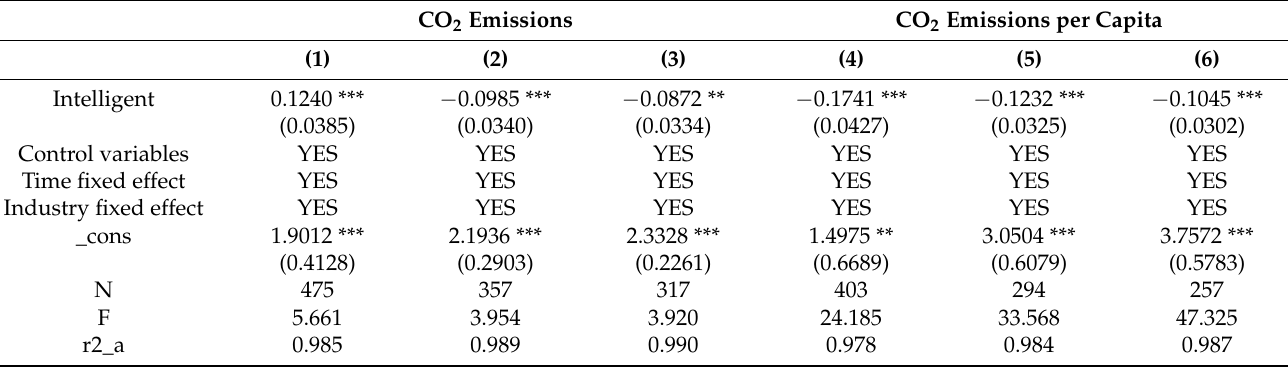
Table 7. Reducing the sample